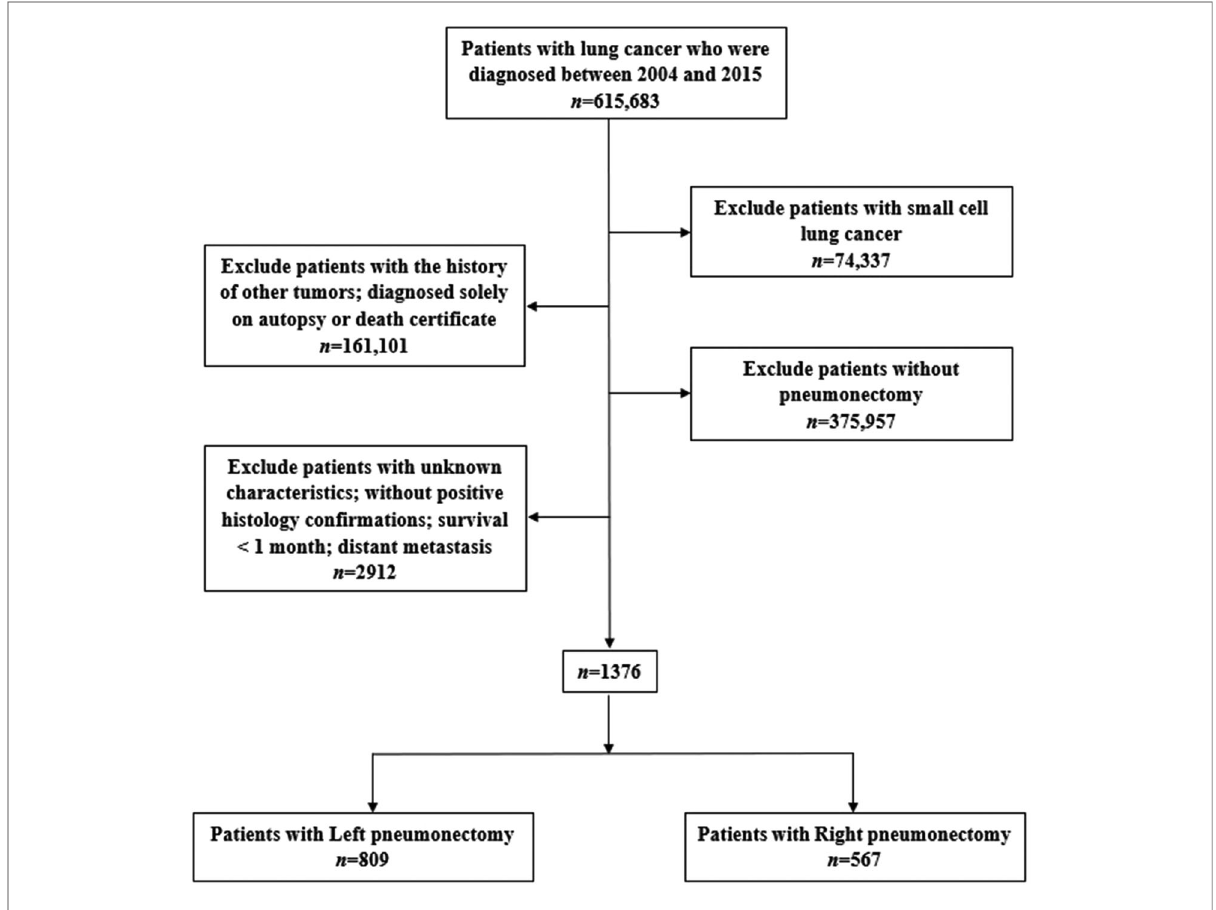
FIGURE 1 Flow chart showing patient